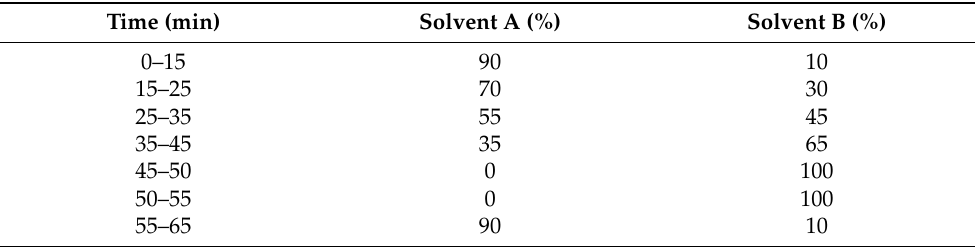
Table 7. HPLC gradient program conditions of methanolic standardized extracts of Cirsium species and